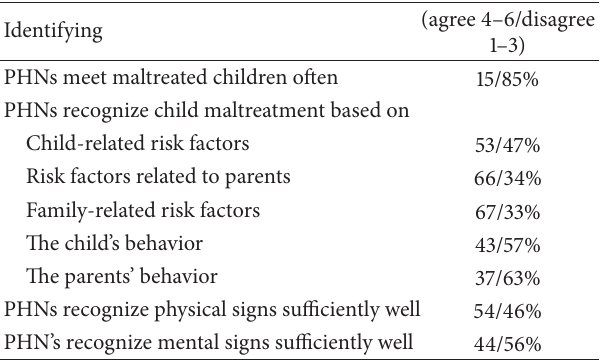
Table 2: Items included in identifying sum variable and the percentages that agree/disagree ( 𝑁 = 367